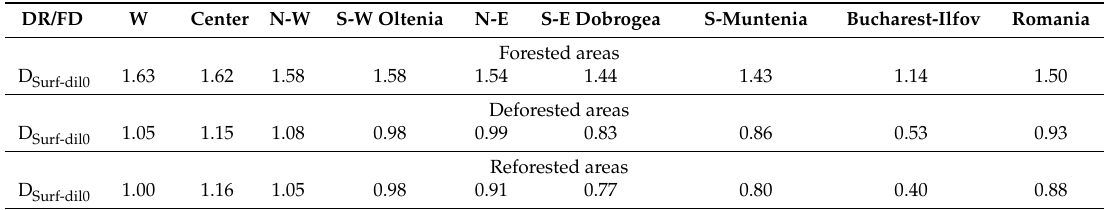
Table 3. Fractal dimension of forested, deforested and reforested areas (D Surf-dil0 ) from development regions of Romania (2000–2012).